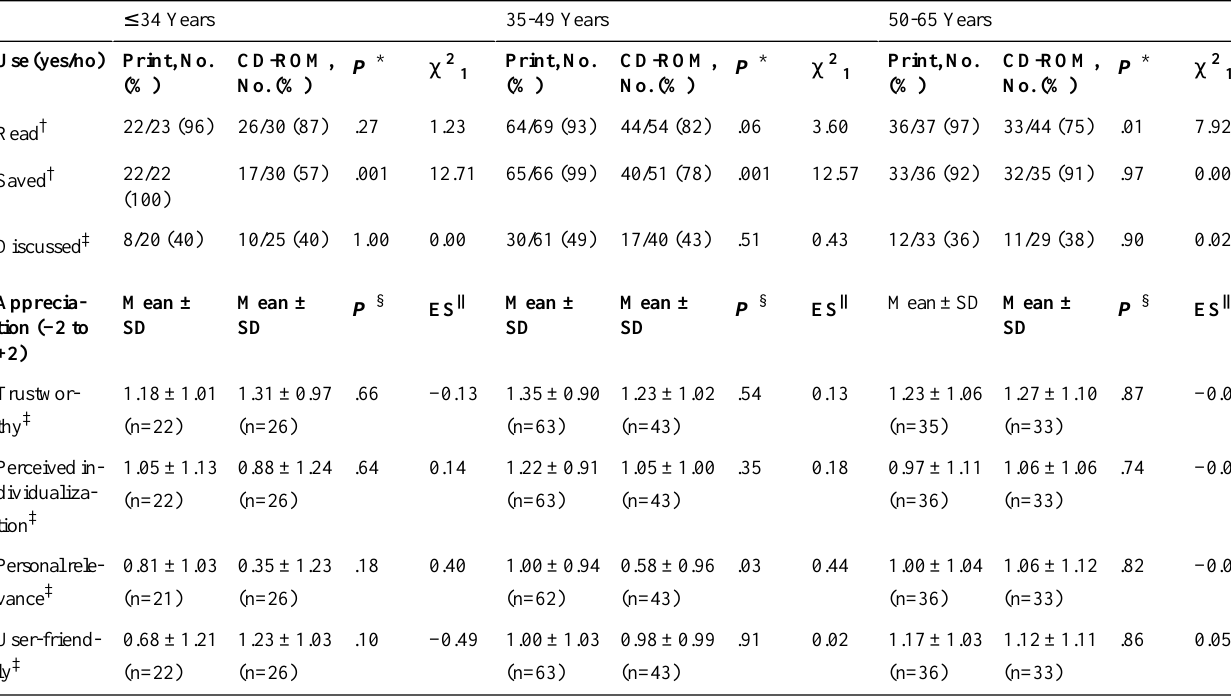
Table 2. Use and appreciation of the print- and CD-ROM-delivered, computer-tailored intervention, by age